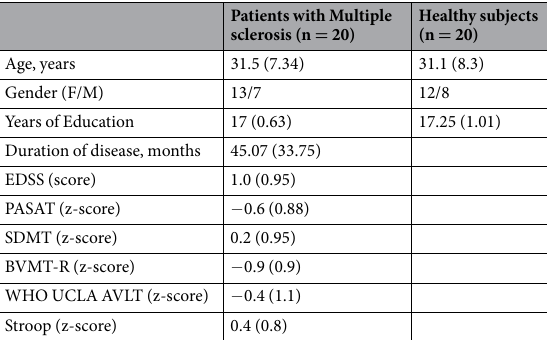
Table 1. Demographic and clinical description of the sample. PASAT (Paced Auditory Serial Addition Task) and SDMT (Symbol Digit Modalities Test) evaluates attention, processing speed, and working memory; EDSS (Expanded Disability Status Scale); Brief Visuospatial Memory Test-Revised (BVMT-R) measures visuospatial memory; and the World Health Organization-University of California-Los Angeles Auditory Verbal Learning Test (WHO UCLA AVLT) measures verbal memory.